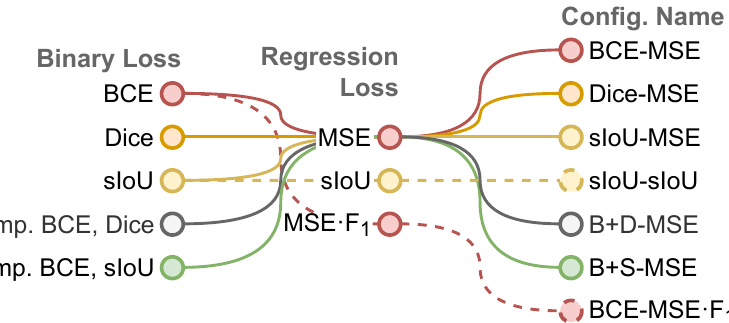
Figure 2. Loss function selection experiments. For each configuration (right column) the binary and regression losses are connected with a line of the same